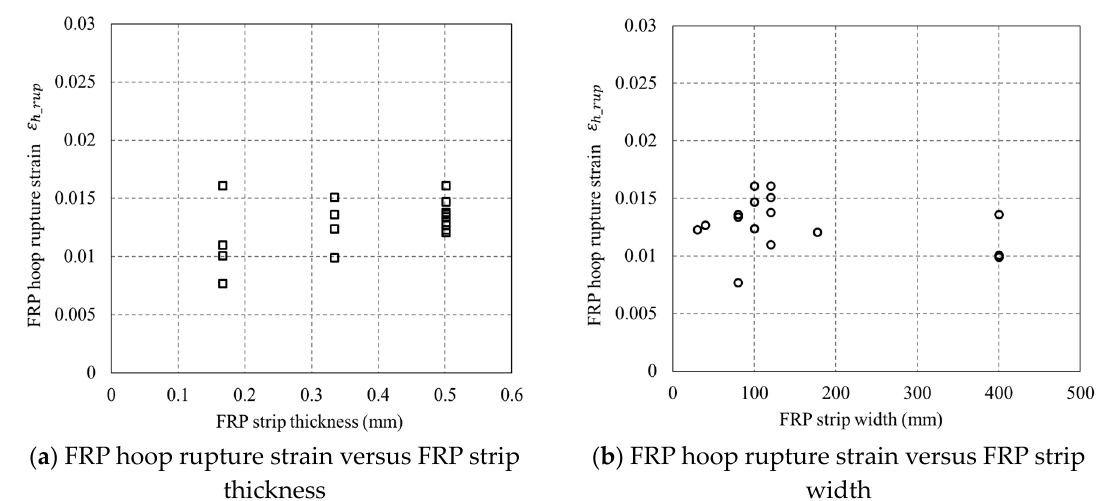
Figure 13. Relationship between FRP hoop rupture strain and FRP strip